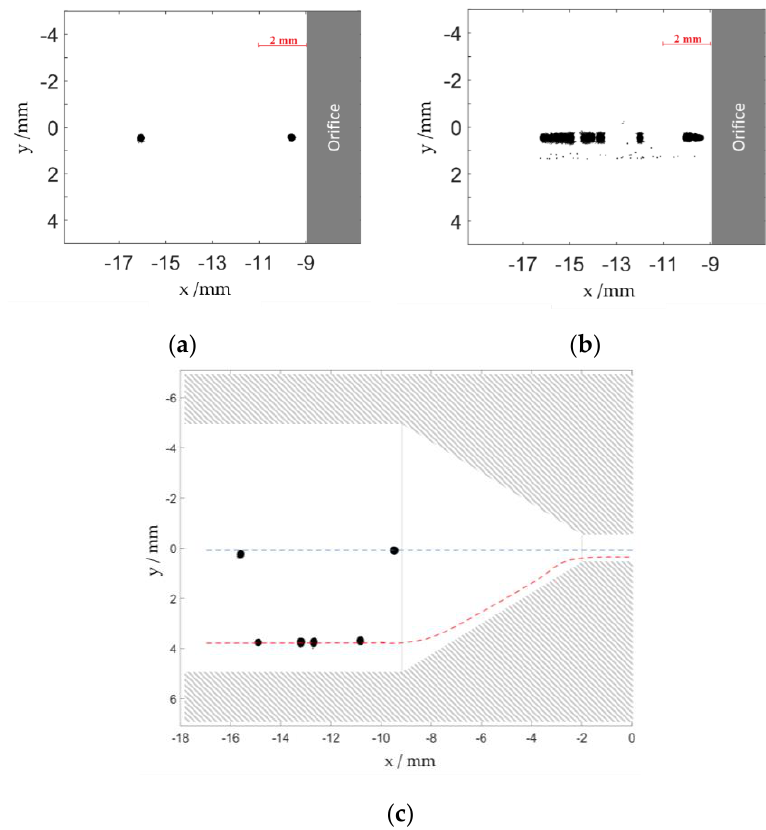
Figure 10. ( a ) Snapshot of droplets with a diameter of about 220 µ m in front of the orifice, which was positioned on the centerline of the flow with a capillary. The flow is from left to right. ( b ) Superimposition of 27 snapshots. ( c ) Superimposition of images where droplets were injected on the center line and close to the wall. The dashed lines represent the expected trajectory of the droplets in the scaled high-pressure homogenizer orifice. The x -axis always shows the distance from the orifice exit.